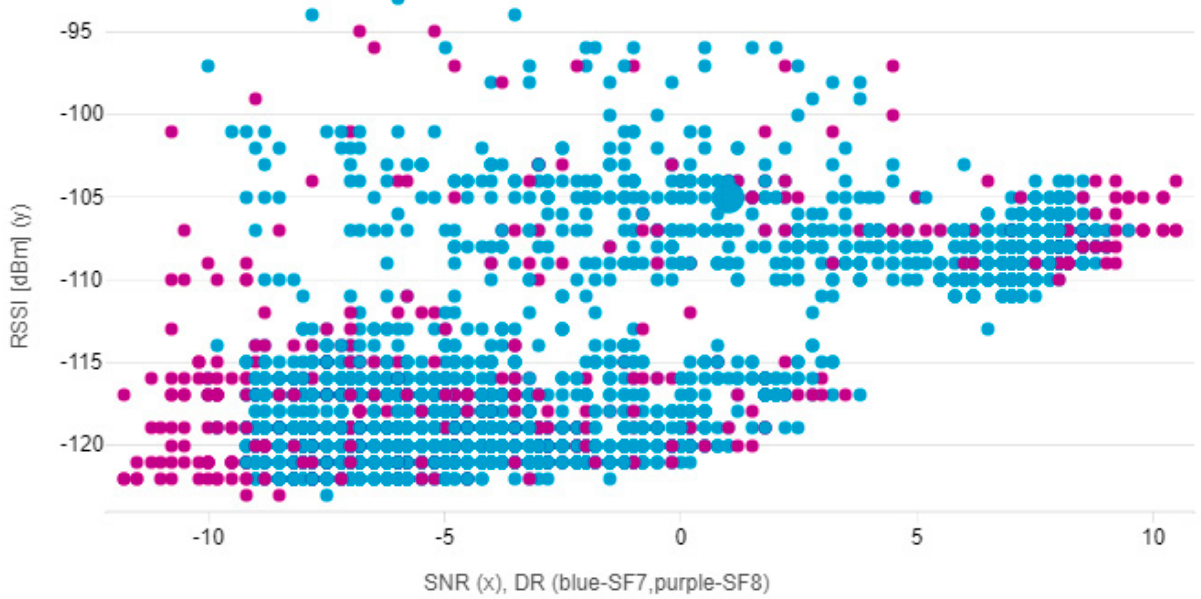
Figure 4. Scatter plot shows the relationship between signal strength and signal-to-noise ratio. The color resolution shows the currently selected spreading factor.